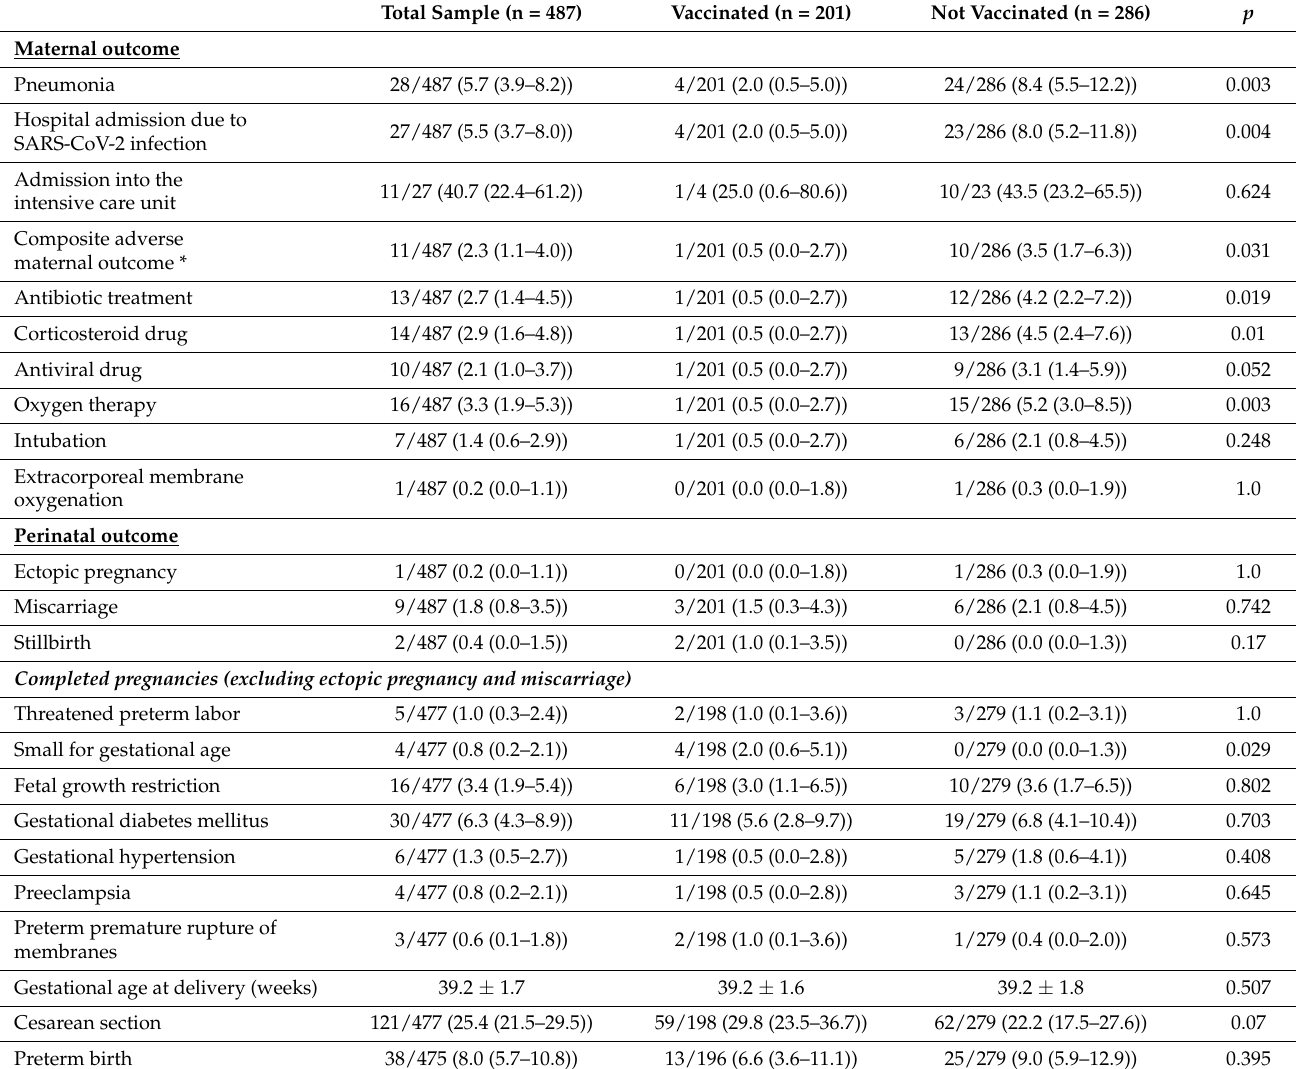
Table 5. Maternal and perinatal outcomes of 487 pregnancies with SARS-CoV-2 infection, overall and according to the vaccination